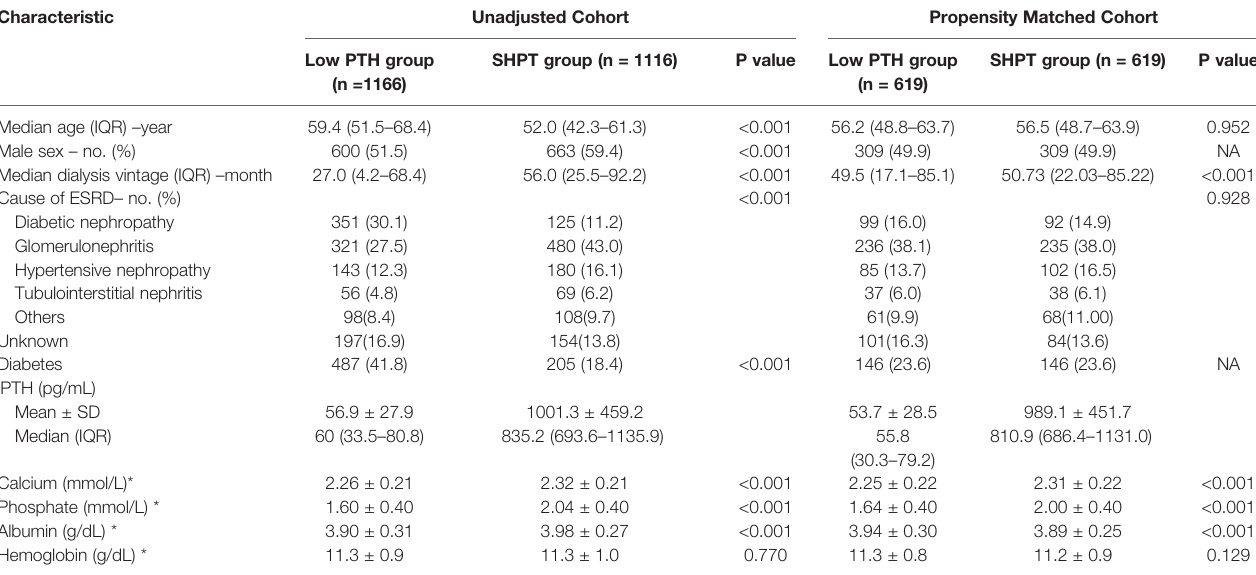
TABLE 1 | Patients ’ baseline characteristics in the unadjusted and propensity-matched cohorts.